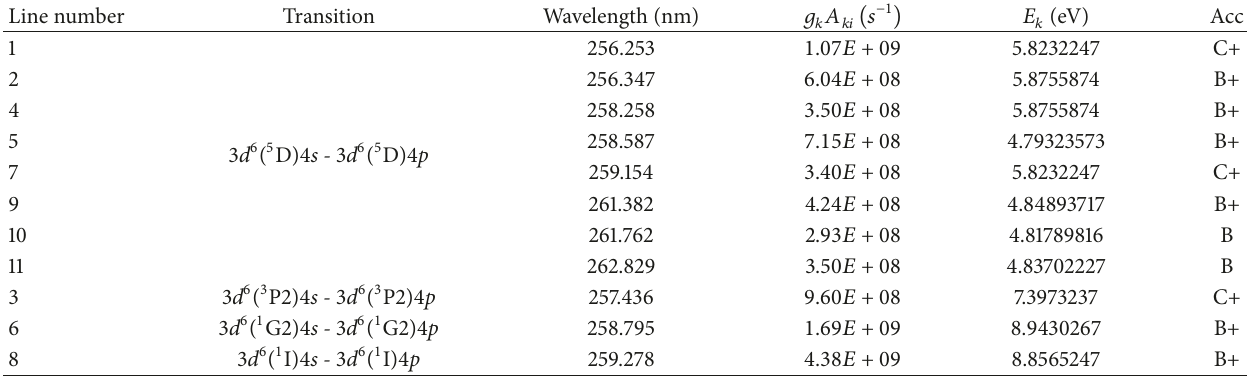
Table 2: Spectroscopic constants of the Fe II lines (Figure 3) used in Boltzmann plot temperature determination. Line